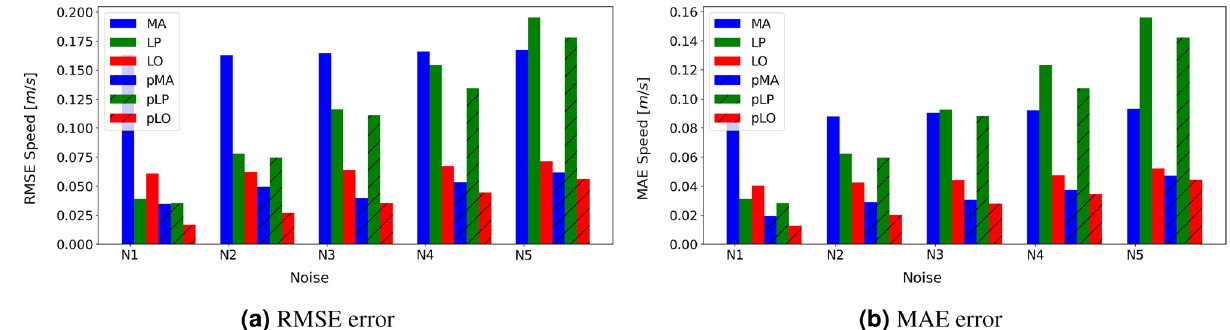
Figure 2. The RMSE and MAE errors for the three reconstruction methods with pMA, pLP, pLO and without ( MA, LP, LO ) the proposed